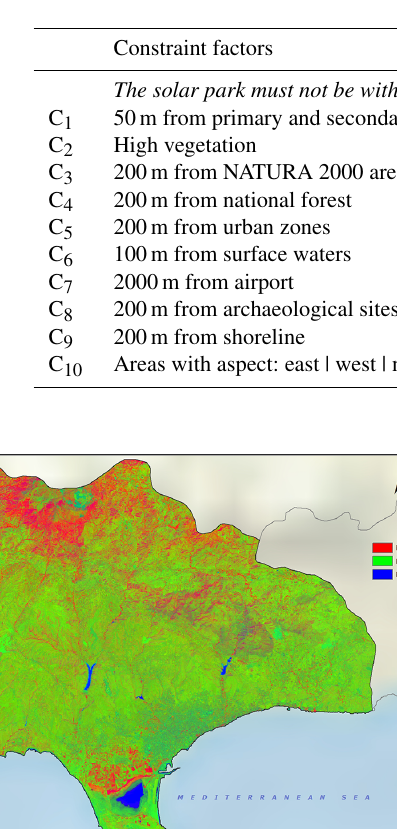
Table 1. Constraint factors of the case study.